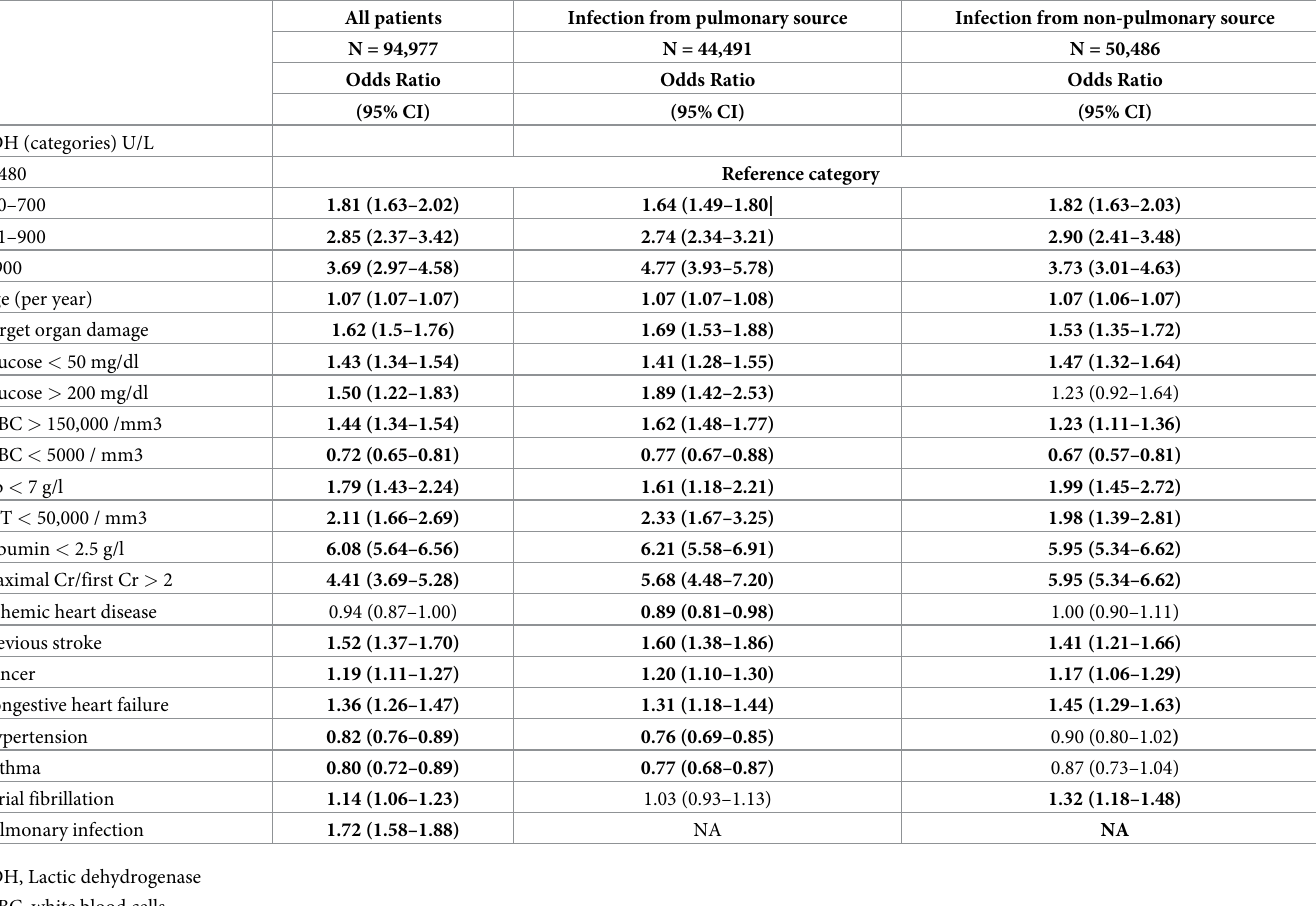
Table 2. Factors associated with 30-day mortality (multivariable logistic